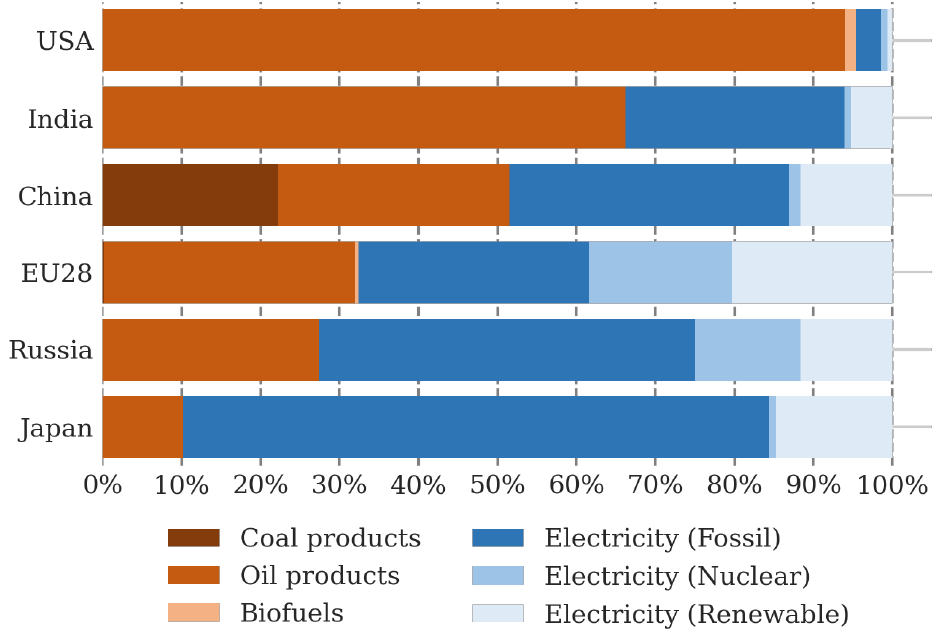
Figure 3. Share of energy sources in the energy mix of selected regions in 2015. Own study based on data from